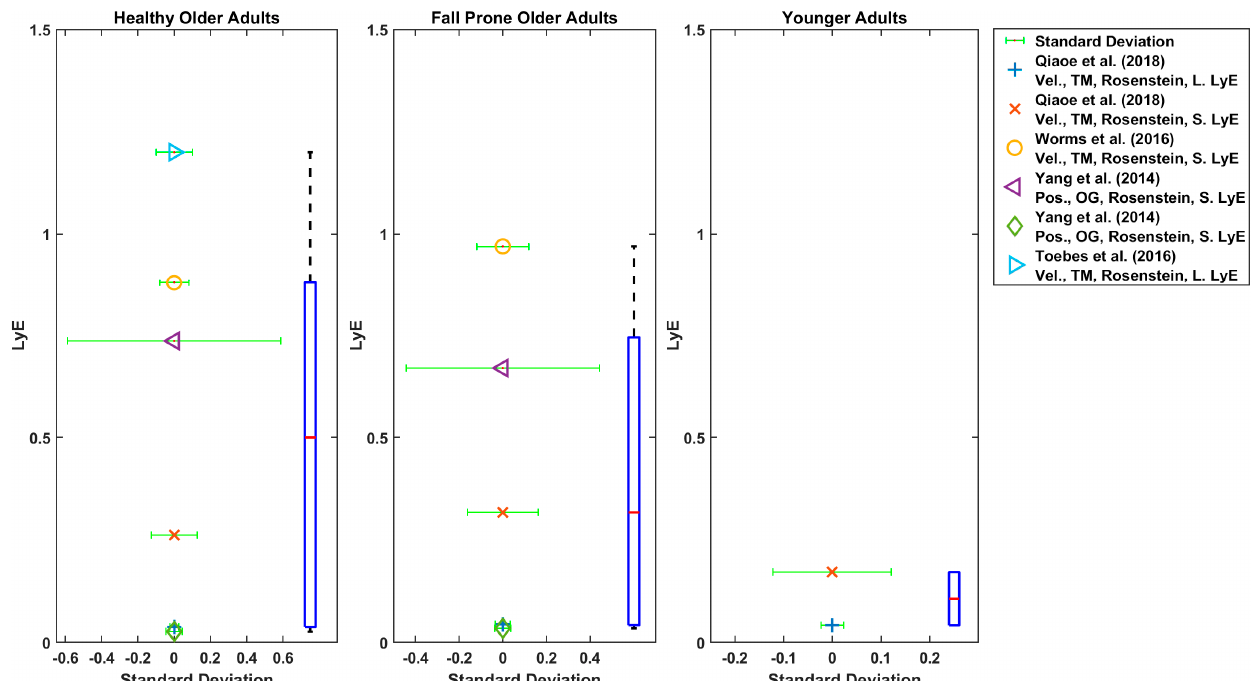
Figure 8. Reported Trunk Short-Term LyE or Long-Term LyE for younger adults.